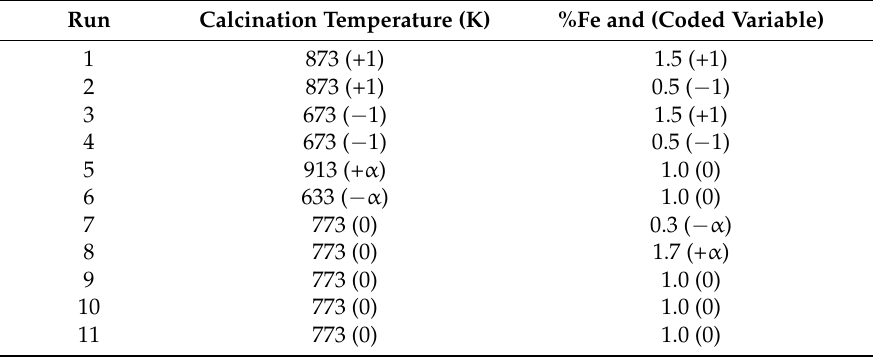
Table 5. Design matrix and experimental results for the central composite factorial design. Run Calcination Temperature (K) %Fe and (Coded Variable) 1 873